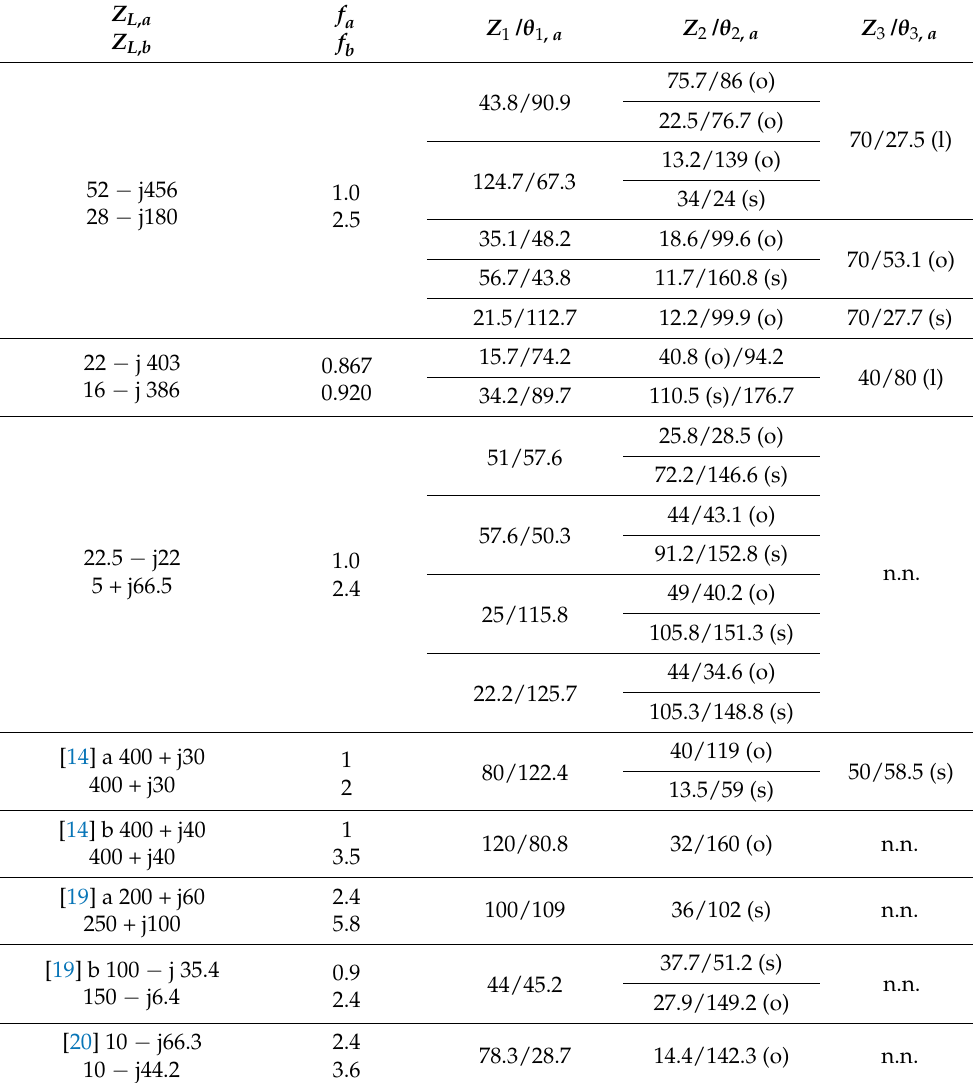
Table 1. Some examples of the matching results 1